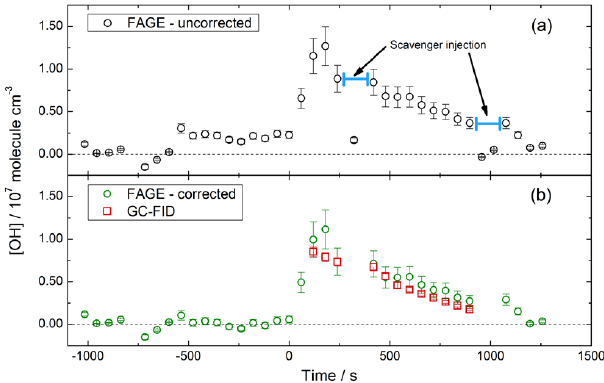
Figure 6. Comparison of [OH] traces measured using the HIRAC FAGE instrument (200Hz PRF) during the photo- oxidation of n -pentane at 1000mbar and 293K before (a) and after (b) , correcting for laser-generated OH due to TBHP photolysis in the OH fluorescence cell. The uncorrected and corrected FAGE signal was converted to [OH] using C OH = 3.6 × 10 − 8 countscm 3 s − 1 molecule − 1 mW − 1 determined using the conventional calibration method for comparison with GC- FID data. The TBHP (3.2 × 10 13 moleculecm − 3 ) and n -pentane (2.1 × 10 13 moleculecm − 3 ) were introduced into the chamber at t ≈ − 500s, and the photolysis lamps were switched on at t = 0s. The [OH] inferred from the HC decay method is also displayed in (b) . Dashed line at y = 0 given for